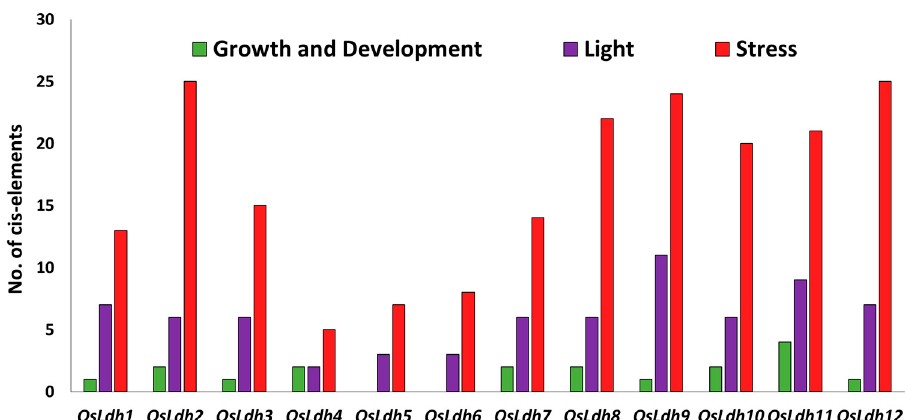
Figure 5. Identification of the cis-elements in the 1 Kb promoter region of rice Ldh genes. Pro- moter analysis was carried out to identify the putative cis-elements present in the promoter region of the Ldh genes. The cis-elements were identified using the PlantCARE database. The Y-axis denotes the number of cis-elements present in the promoter region of each of the genes, regulating growth and development, light and stress responsiveness. Green colour denotes cis-elements involved in growth and development, purple colour denotes light responsiveness and red colour denotes stress responsiveness.